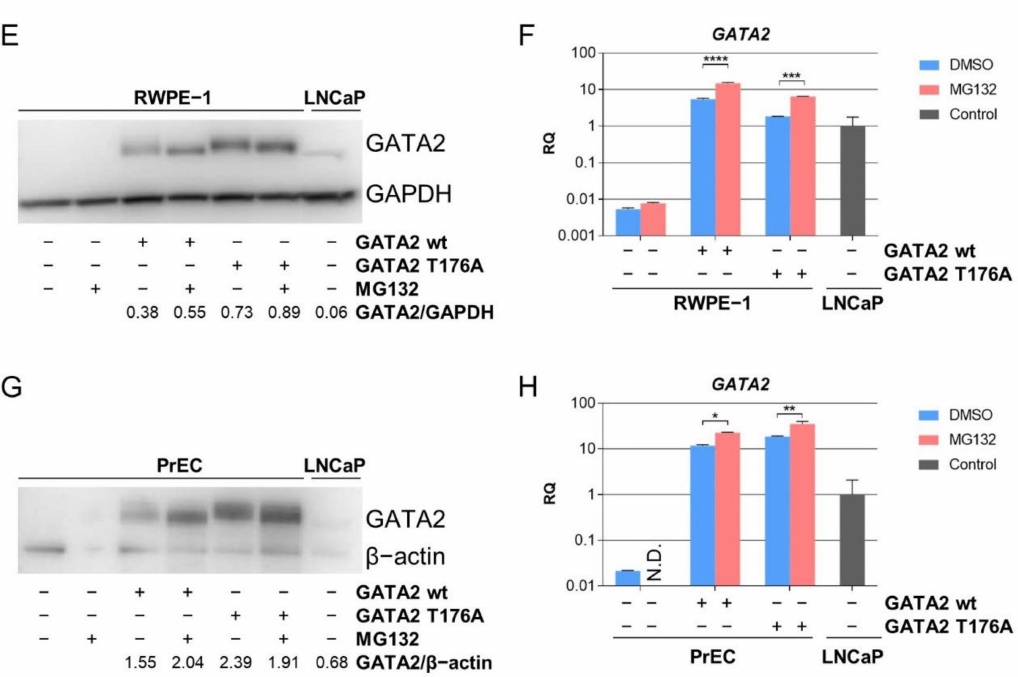
Figure 2. GATA2 proteasome-mediated restriction is present in different TA cells. The basal-like TA cells were split once 48 h post-transduction and treated with 10 µ M MG132 for 8 h before being harvested. ( A ) Western blot and ( B ) qPCR of 957E/hTERT cells, ( C ) Western blot and ( D ) qPCR of EP156T cells, ( E ) Western blot and ( F ) qPCR of RWPE-1 cells, and ( G ) Western blot and ( H ) qPCR of PrEC cells. LNCaP cells were used as positive control without MG132 treatment. Error bars represent standard error of the mean expression level (RQ) based on the RQmin/max of 95% confidence level. N.D. = not detected. * p ≤ 0.05, ** p ≤ 0.01, *** p ≤ 0.001, **** p ≤ 0.0001 by using one-way